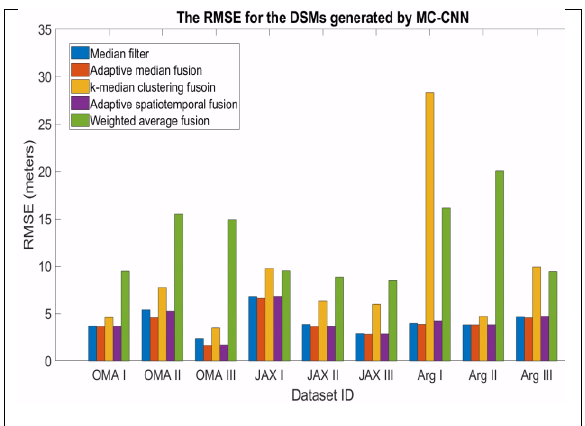
Figure 3. A comparison between fusion algorithms for DSMs generated from Census and MC-CNN.